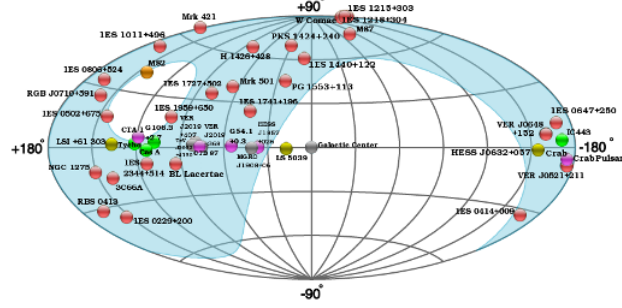
Table 1: Extragalactic sources of TeV gamma-ray emission detected by VERITAS. Some redshifts are considered